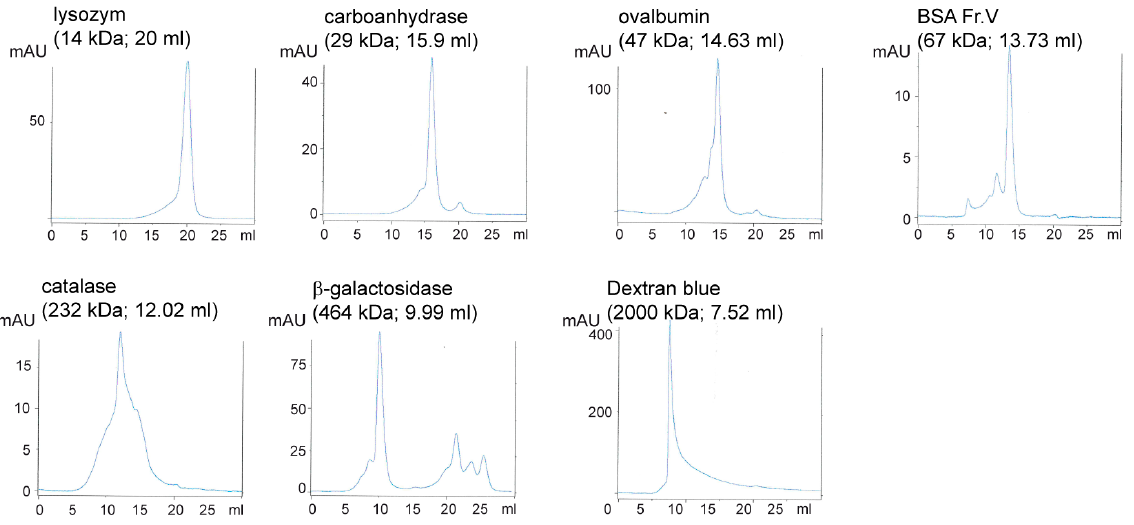
( C ) Table of selected NitFhit fusion proteins and Nit2 homologous genes.